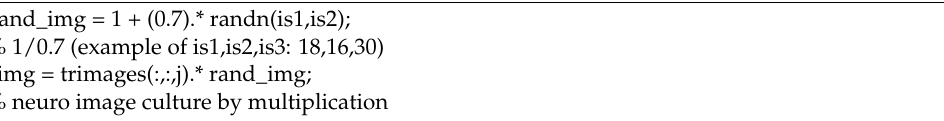
Box 1. The MATLAB code for training image data augmentation by Gaussian brightness control. rand_img = 1 + (0.7).*